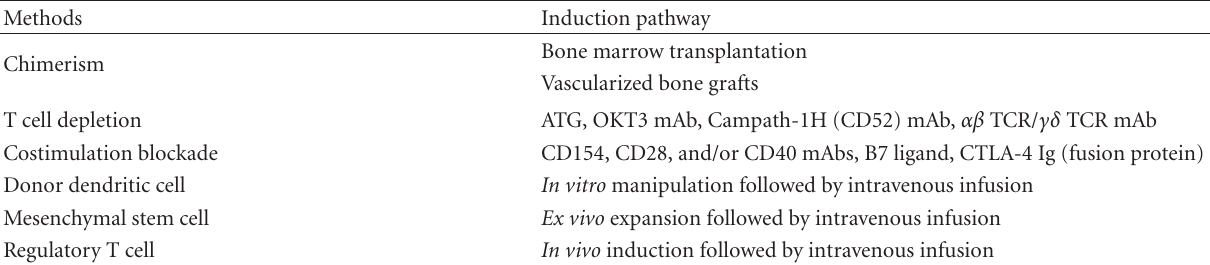
Table 1: Methods of tolerance induction for VCA listed